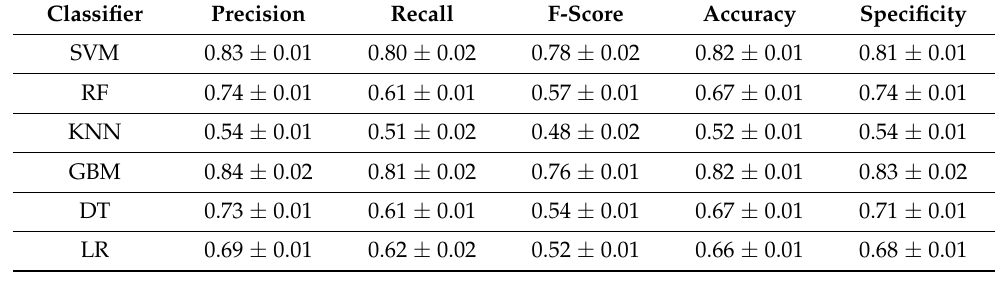
Table 1. Performance indices for 5-fold CV using different ML classifiers.